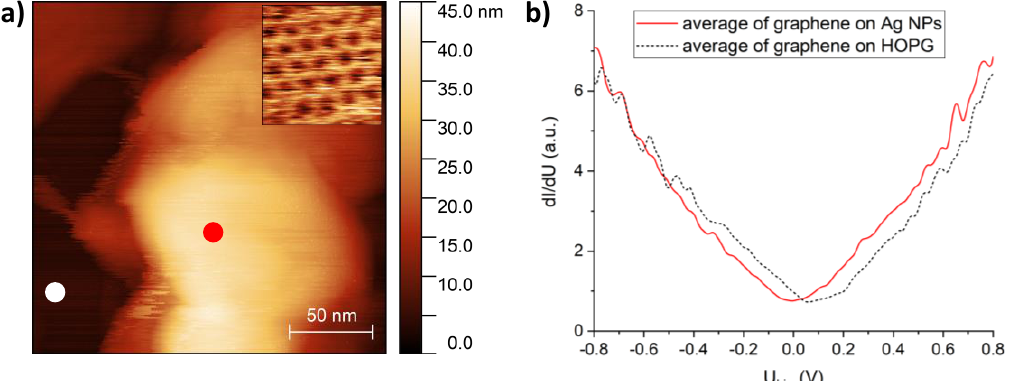
Figure 3. ( a ) Scanning tunneling microscopy (STM) image of a graphene-covered Ag nanostructure. Dark-colored regions correspond to graphene on the HOPG substrate. Tunneling parameters: I = 0.4 nA, U = 0.8 V. Atomic-resolution STM image of silver-supported graphene is shown in the inset. ( b ) The dI/dU spectra measured on graphene–HOPG (dashed line) and graphene–Ag (red line). The STS measurements were performed at the graphene–HOPG and graphene–Ag positions marked in ( a ) with white and red symbols, respectively.